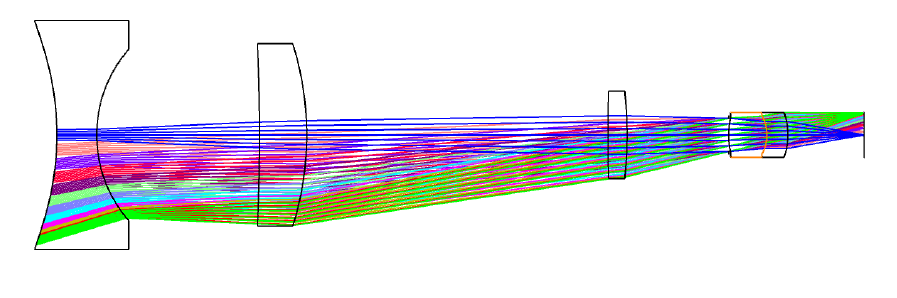
Figure 1. Optical design of the SW camera. The total axial length equals 85.5 mm. The system consists of three singlet lenses and an achromatic doublet. The aperture stop is situated at the front side of the achromatic doublet. The square detector has a size of 4.92 mm × 4.92 mm. The half FOV is 70°. The sampling of the 12 fields (12 different colors) has been chosen, such that they are separated by the same angle of